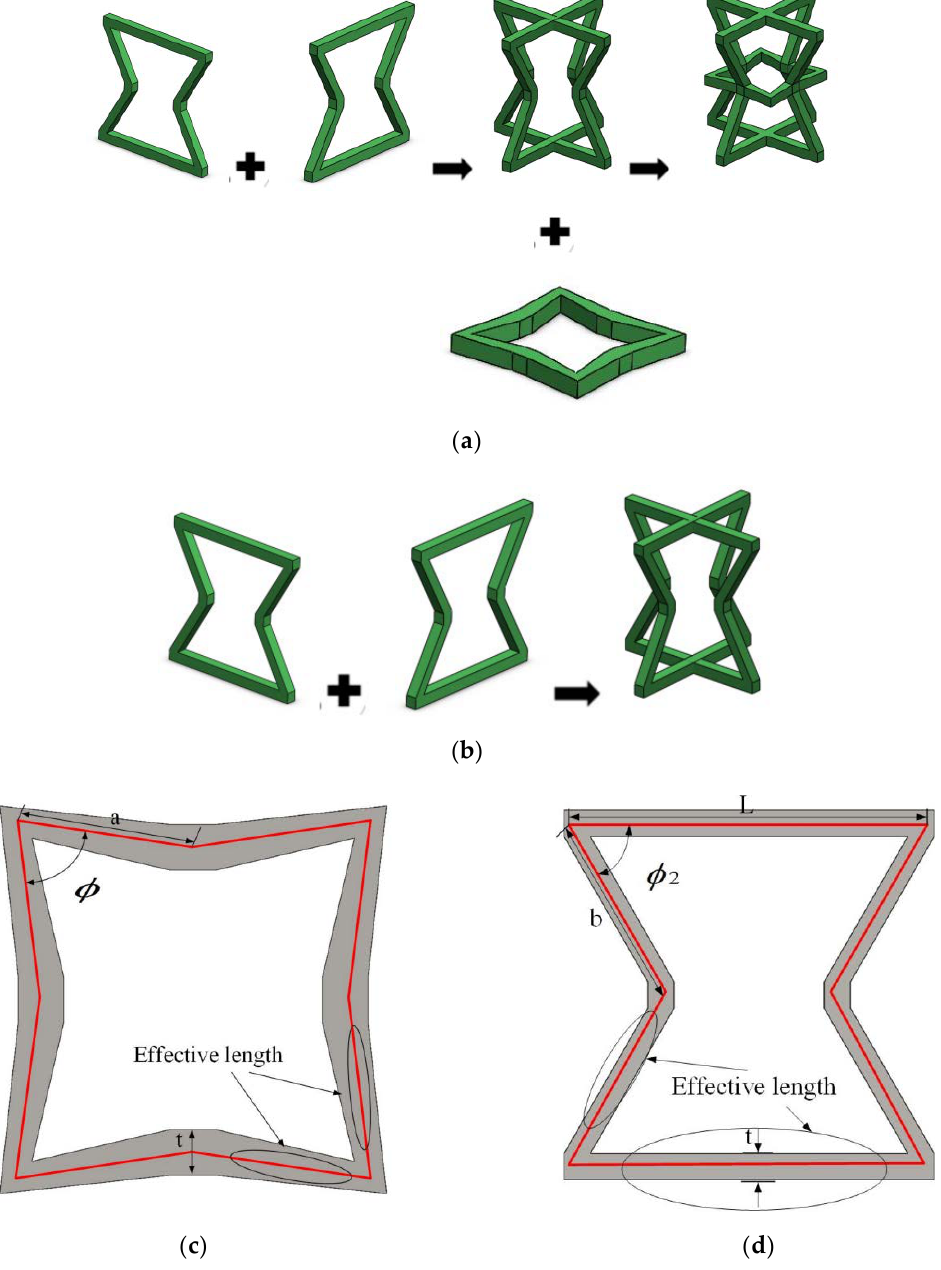
Figure 1. Modified NPR 2D and 3D structure configurations. ( a ) Modified 3D NPR structure configuration; ( b ) Schematic diagram of the 3D component unit structure of the control model; ( c ) Geometric structure configuration of 2D star structure components; ( d ) geometric structure configuration of 2D concave structure components. Table 1. The three designed model plane parameters.